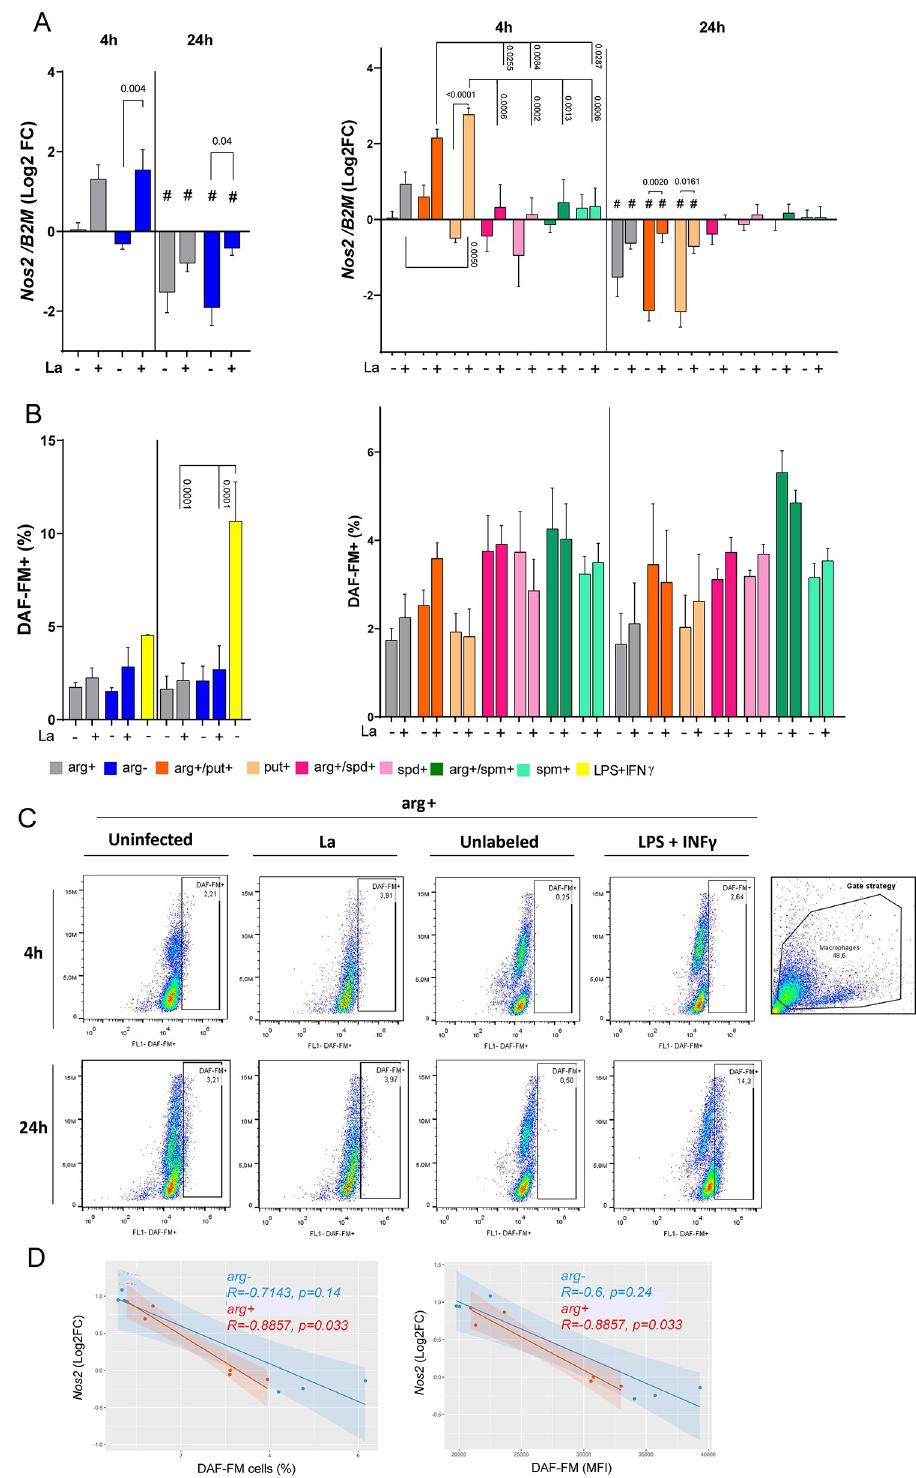
Fig 3. Relative expression of Nos2 and NO production in BALB/c macrophages infected or not with L . amazonensis with or without polyamines supplementation. Macrophages (5x10 6 ) (A) and (1x10 6 ) (B, C) were supplemented with putrescine (put+), spermidine (spd+), spermine (spm+) with or without L-arginine (arg+) concomitant to L . amazonensis infection (MOI 5:1) for 4h, and after 24h in complete medium. The RNA was extracted